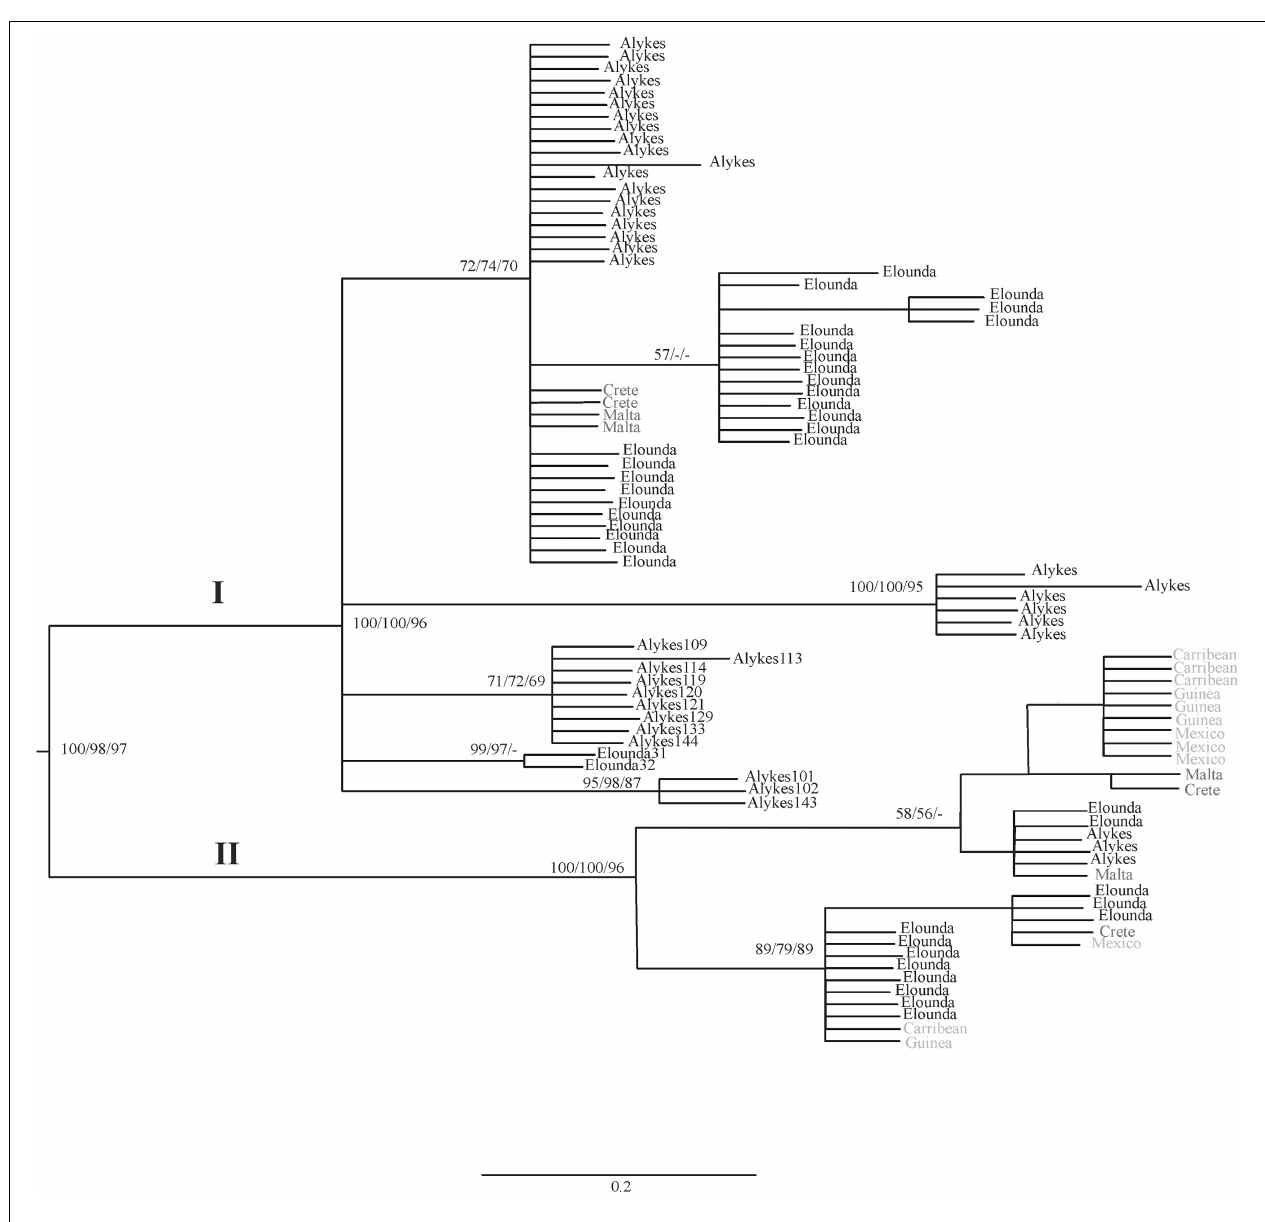
FIGURE 3 | Consensus tree constructed using Bayesian Inference for the COI marker. Branch support values (higher than 50%) for Bayesian Inference, Maximum likelihood and Neighbor-joining are shown in each clade,